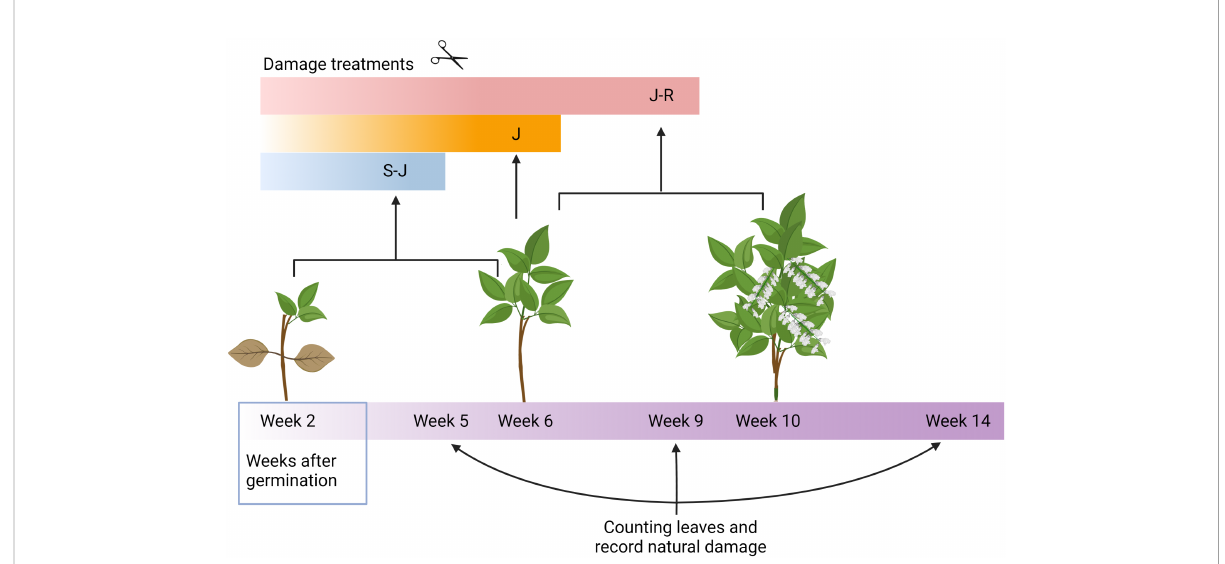
FIGURE 1 Schematic representation of the experimental design. Damage treatments on lima bean plants consisted of arti fi cial damage on leaves at two different ontogenetical stages (S-J and J-R) or at one